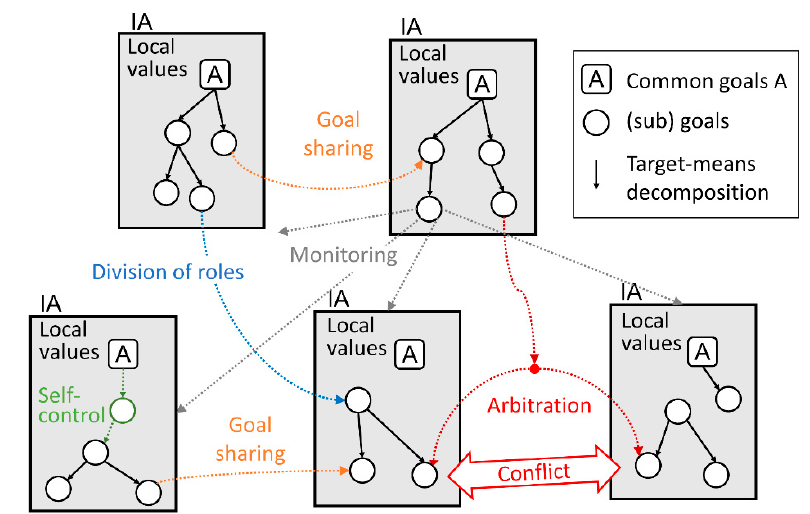
Figure 2. Sharing goals in an IA group: various IAs generate di ff erent sub-goals and specialize themselves to those sub-goals in response to their environment, bodies, and tasks. Each IA conducts target-means decomposition, arbitration, and, at times, checks consistency. They also carry out, in cooperation with other IAs, task allotment, goals sharing, arbitration, monitoring, and so forth. Individual IAs carry out activities toward concrete sub-goals within a certain time